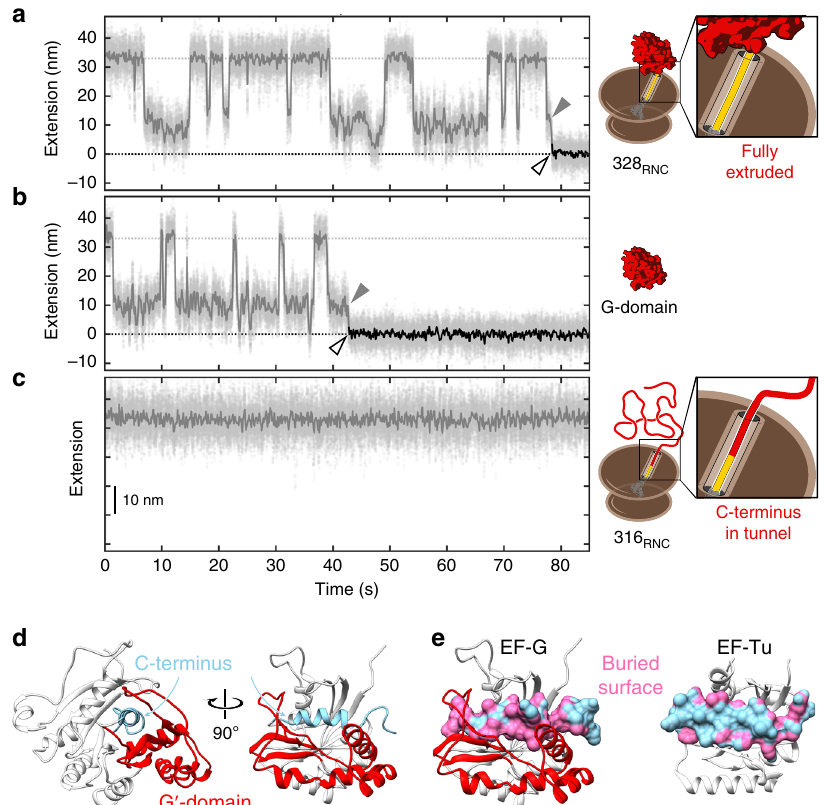
Fig. 6 Refolding of the G-domain on and off the ribosome. a Refolding of the ribosome-bound G-domain (328 RNC ). Starting with the unfolded G-domain at t = 0, refolding against a constant force of 3.5 pN is followed by recording changes in molecular extension. The domain visits several partially folded states with extensions between the unfolded (gray dotted line) and folded (black dotted line) states. At least one state represents an on-pathway folding intermediate (gray arrowhead) that is visited immediately before the domain reaches the folded state (open arrowhead). Gray dots: raw data (1000 Hz), solid lines: fi ltered data (30 Hz). b Same as a for the isolated G-domain. The overall trajectory resembles that of the ribosome-bound G-domain. c Same as a for a shorter nascent chain (316 RNC ). In contrast to 328 RNC , the shorter nascent chain does not exhibit clear folding transitions, suggesting that the C- terminal amino acids of the G-domain, which remain con fi ned within the exit tunnel at this chain length, are essential for formation of productive folding intermediates. d Cartoon representation of the G-domain. The G ′ insertion (red) and the remaining part of the G-domain (white) enclose the C-terminal region (light blue) containing the last α -helix. e G-domains from EF-G (left) and EF-Tu (right) in the same orientation as the right panel in d with the C-terminal region shown in surface representation. The surface area of this region that is buried in the native structure is shown in pink. Whereas the